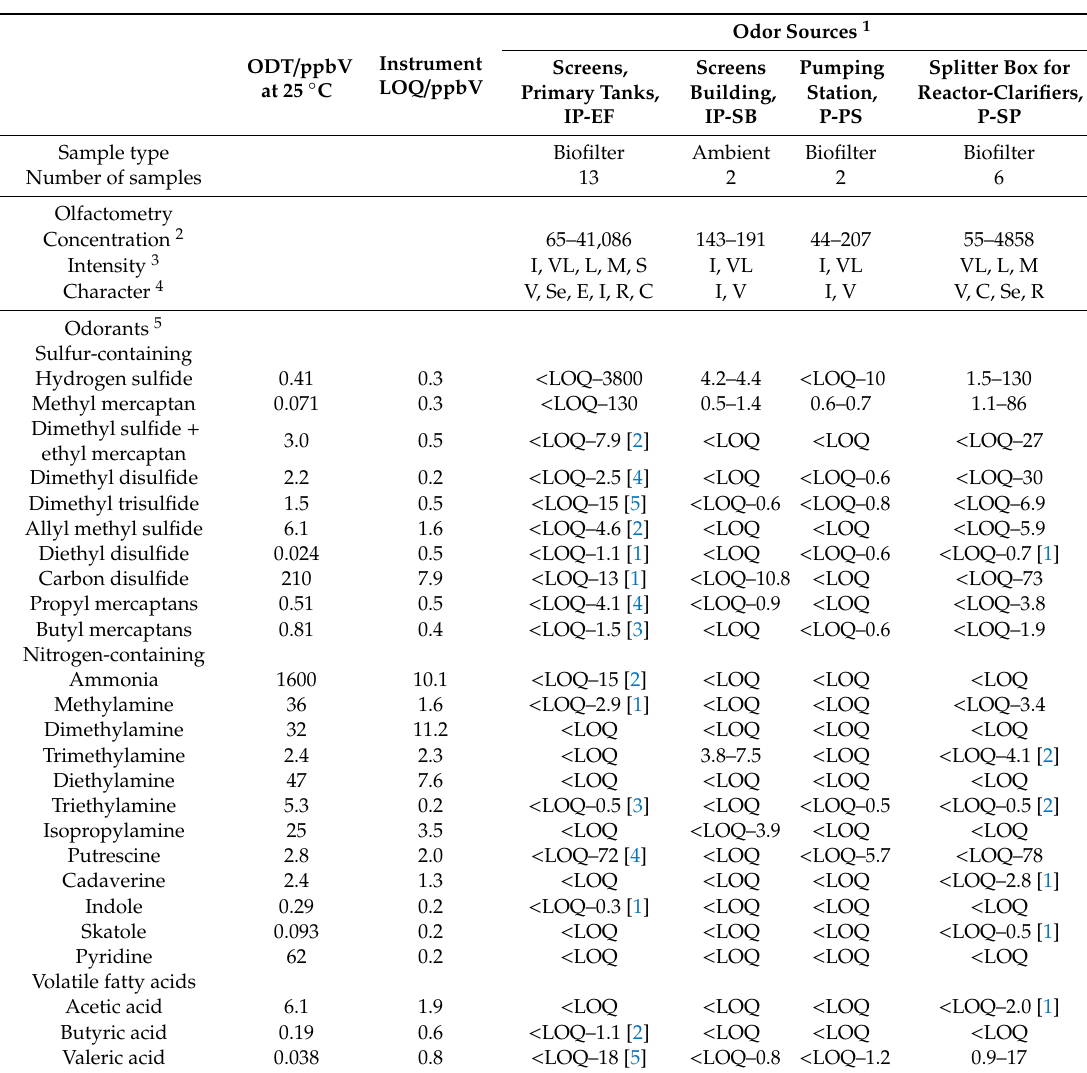
Table 5. Sensory data and SIFT-MS concentration data (in ppbV) for odor sources from influent and primary treatment. The range of values for each source is shown. See the text and table footnotes for more